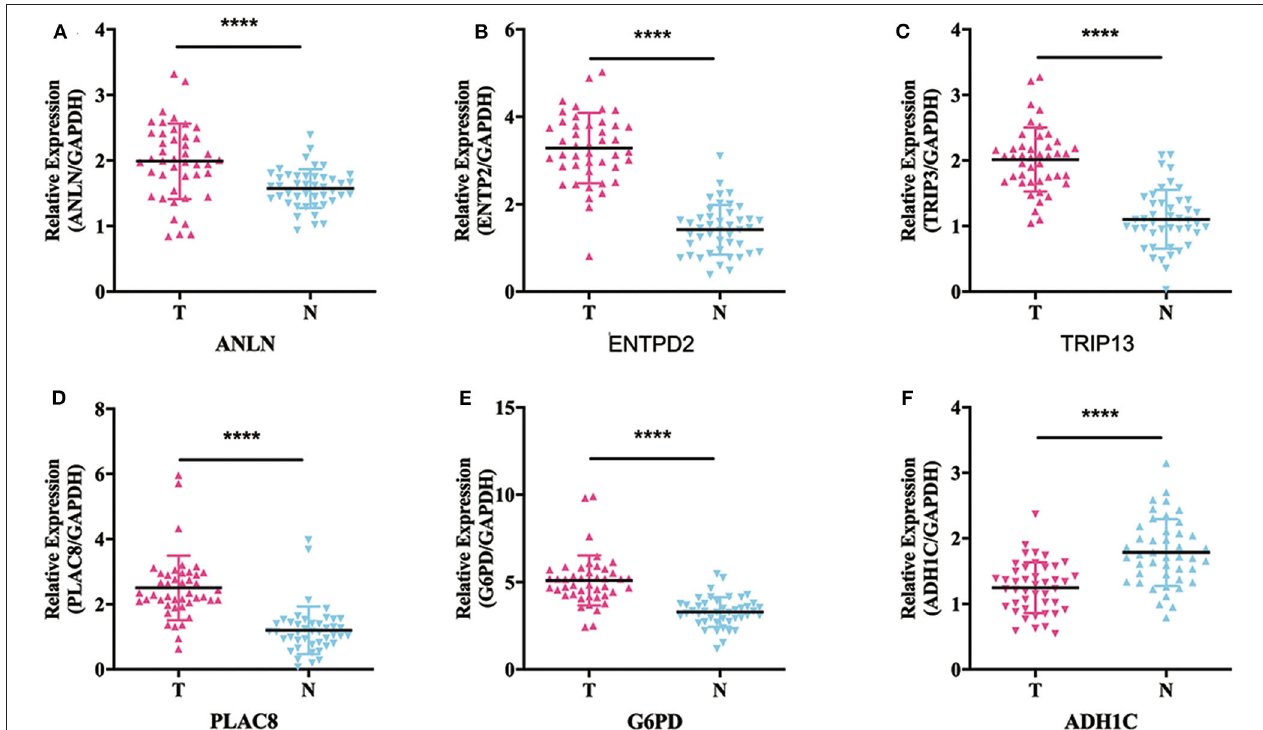
FIGURE 6 | The results of qRT-PCR in six genes. (A–E) ANLN, ENTPD2, TRIP13, PLAC8, and G6PD were highly expressed in HCC tissues. (F) ADH1C was lowly expressed in HCC